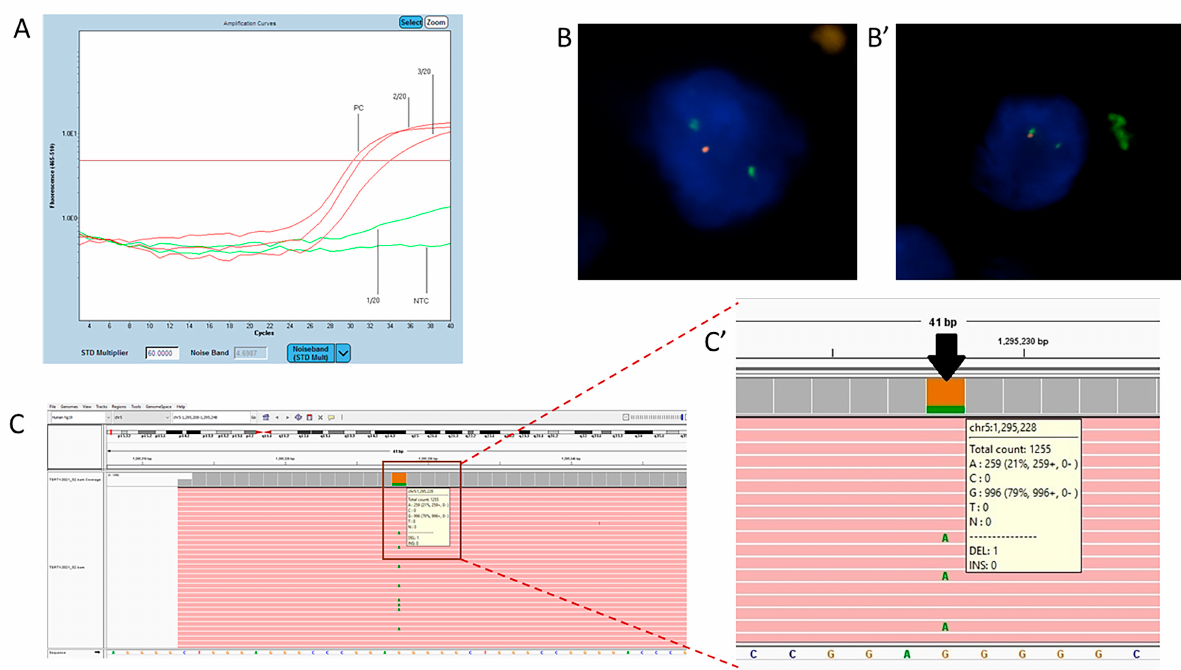
Figure 1. Application of fluorescence in situ hybridization (FISH), next-generation sequencing (NGS), and quantitative polymerase chain reaction (qPCR) in the genetic diagnosis of glioma. ( A ) Representative screenshot of an isocitrate dehydrogenase 1 ( IDH1 ) mutation. Red amplification curves represent positive signals for the mutation in exon 4, codon 132 of the IDH1 gene detected in positive control (PC) and two patients’ samples (2/20 and 3/20). The test does not distinguish between IDH1 changes: R132H (c.395G>A), R132C (c.394C>T), R132S (c.394C>A), R132G (c.394C>G), R132L (c.395G>T), R132P (c.395G>C). Sample 1/20 negative for the presence of mutations in IDH1 codons 132 and 100 and the IDH2 gene at codons 140 and 172 (IDH-RT38, Entrogen). ( B ) Applications of FISH in genetic diagnostics in glioma on biological material collected by stereotactic biopsy. Deletion of 1p32 (cell on the left). ( B’ ) Deletion of 19q13 (cell on the right) (Abbott, Molecular). ( C ) Representative screenshot of a telomerase reverse transcriptase ( TERT ) variant using Integrative Genomics Viewer (IGV). Aligned NGS data produced with Entrogen’s Targeted Hotspot Panel 16 kit. ( C’ ) Close-up of TERT promoter variant NC_00005.9: g.1295228G>A; (commonly called C228T mutation) Reported as pathogenic.